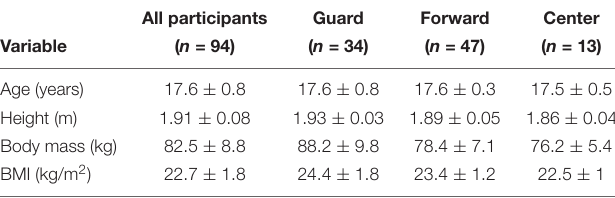
TABLE 1 | Anthropometric characteristics of the participants by playing position. All participants Guard Forward